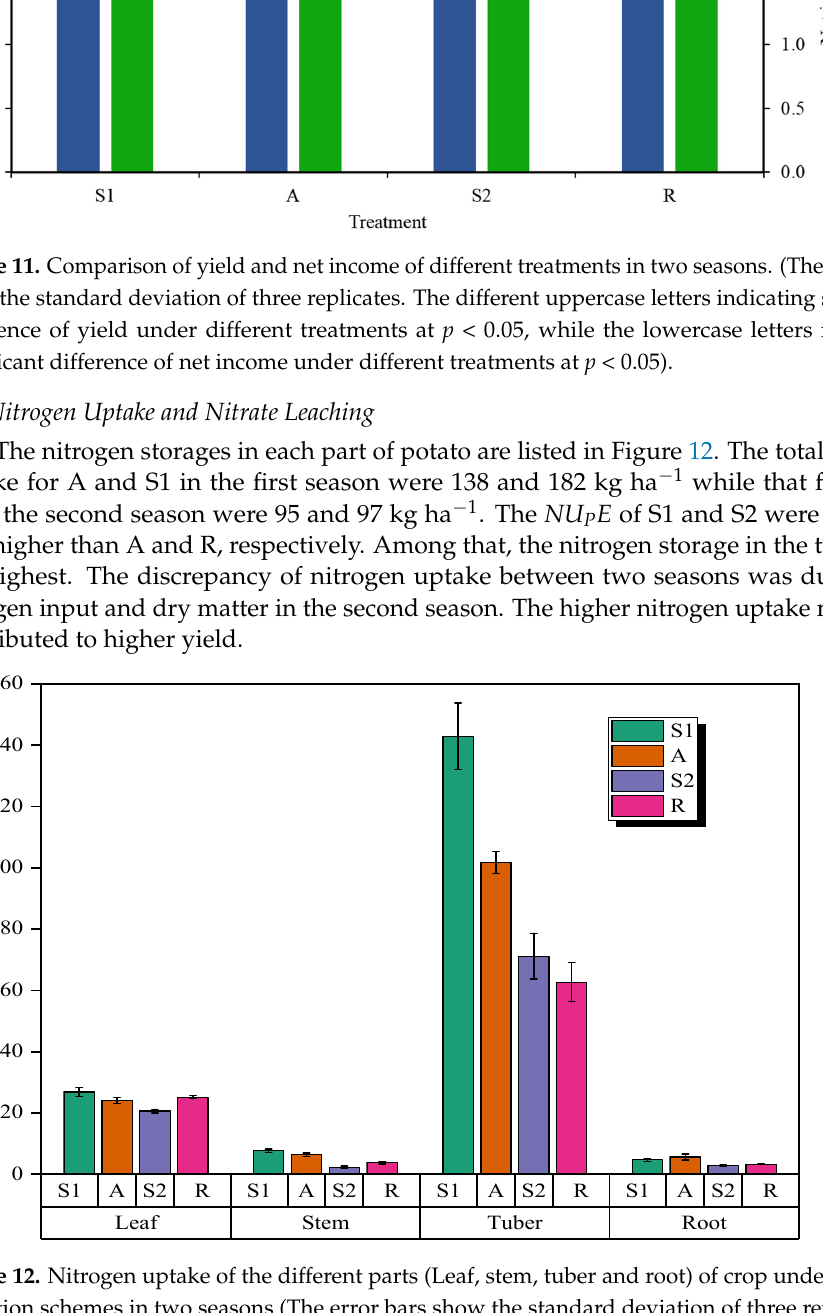
Figure 12. Nitrogen uptake of the different parts (Leaf, stem, tuber and root) of crop under different irrigation schemes in two seasons (The error bars show the standard deviation of three replicates). As shown in Figure 13, the accumulative nitrate leaching at the outlet of the lysime- ters of S1 and S2 were 105 and 54 kg ha − 1 , which were 51 and 22% higher than A and R, respectively. The higher nitrate leaching in the first season is likely due to higher N supply and evenly distributed irrigation and precipitation. Though the total irrigation amount of A was higher than S1 in first season, the irrigation activities were concentrated in the early stage, while during late growth stage, less water was supplied due to large amount of rainfall. Such as from June 3 to 23, there was only 4.8 mm irrigation for A. Another possible reason is that frequent irrigation in treatment S increased the chance of nitrate leaching, while large amount of irrigation in treatment A for each time diluted the concentration of nitrogen. According to the results of this study, intensive irrigation might lead to nitrate leaching. In addition, we further analyzed the relationship between the nitrate leaching and water supply in terms of precipitation plus irrigation during second season (Figure 14). The linear regression can describe the relationships well between precipitation plus irrigation and nitrate leaching (R 2 = 0.80). Huang et al. [36] also reported similar relation- ship between monthly precipitation plus irrigation and monthly nitrate leaching. The ac- cumulated soil nitrate after crop harvest matched the accumulative nitrate leaching. Higher accumulated soil nitrate of A and R (550 and 78 kg ha − 1 ) coincide with lower nitrate leaching in the two seasons, respectively. Furthermore, we also measured the soil nitrate content at different soil depths to evaluate the soil nitrate distribution at root zone (Figure 15). The nitrate content of A changed from 5.1 to 10.8 kg ha − 1 at 0–50 cm soil layer in first season, higher than that of S1 except for the depth of 30–40 cm. The same trend was ob- tained in the second season, nitrate content of R ranged from 8.0 to 14.3 kg ha − 1 . The incre- ment of soil nitrate content in the second season might be due to decreased amount of precipitation plus irrigation (average 297 mm) compared with the first season (average 807 mm), resulting in a decrease in nitrate leaching and an increase in soil nitrate stock.